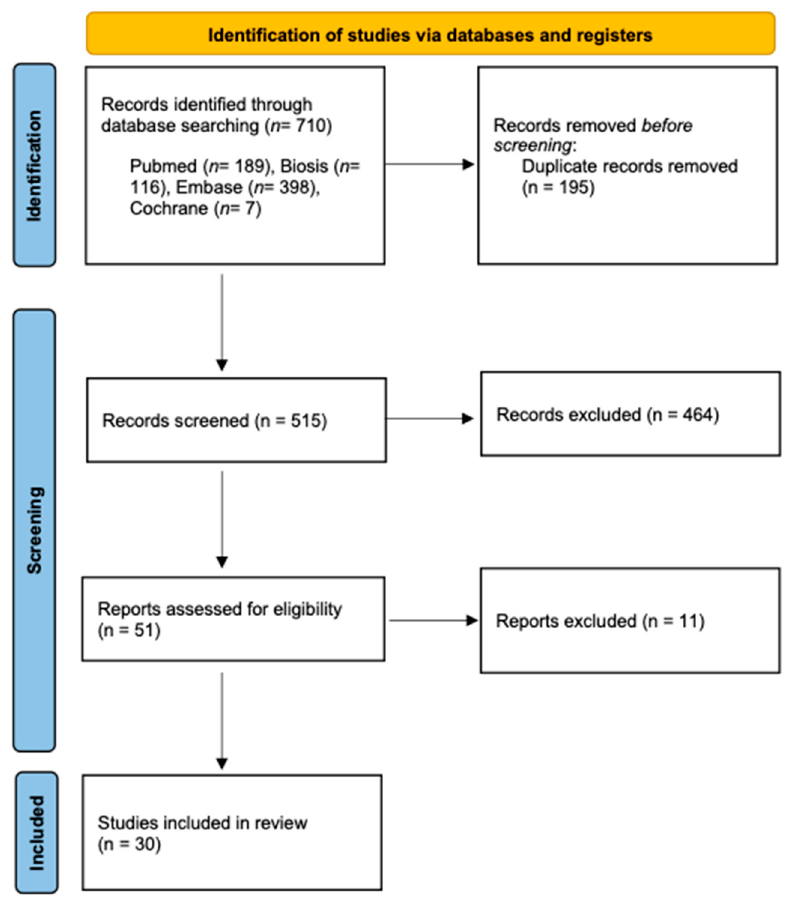
Figure 1. PRISMA flow diagram showing the article selection in this systematic review.